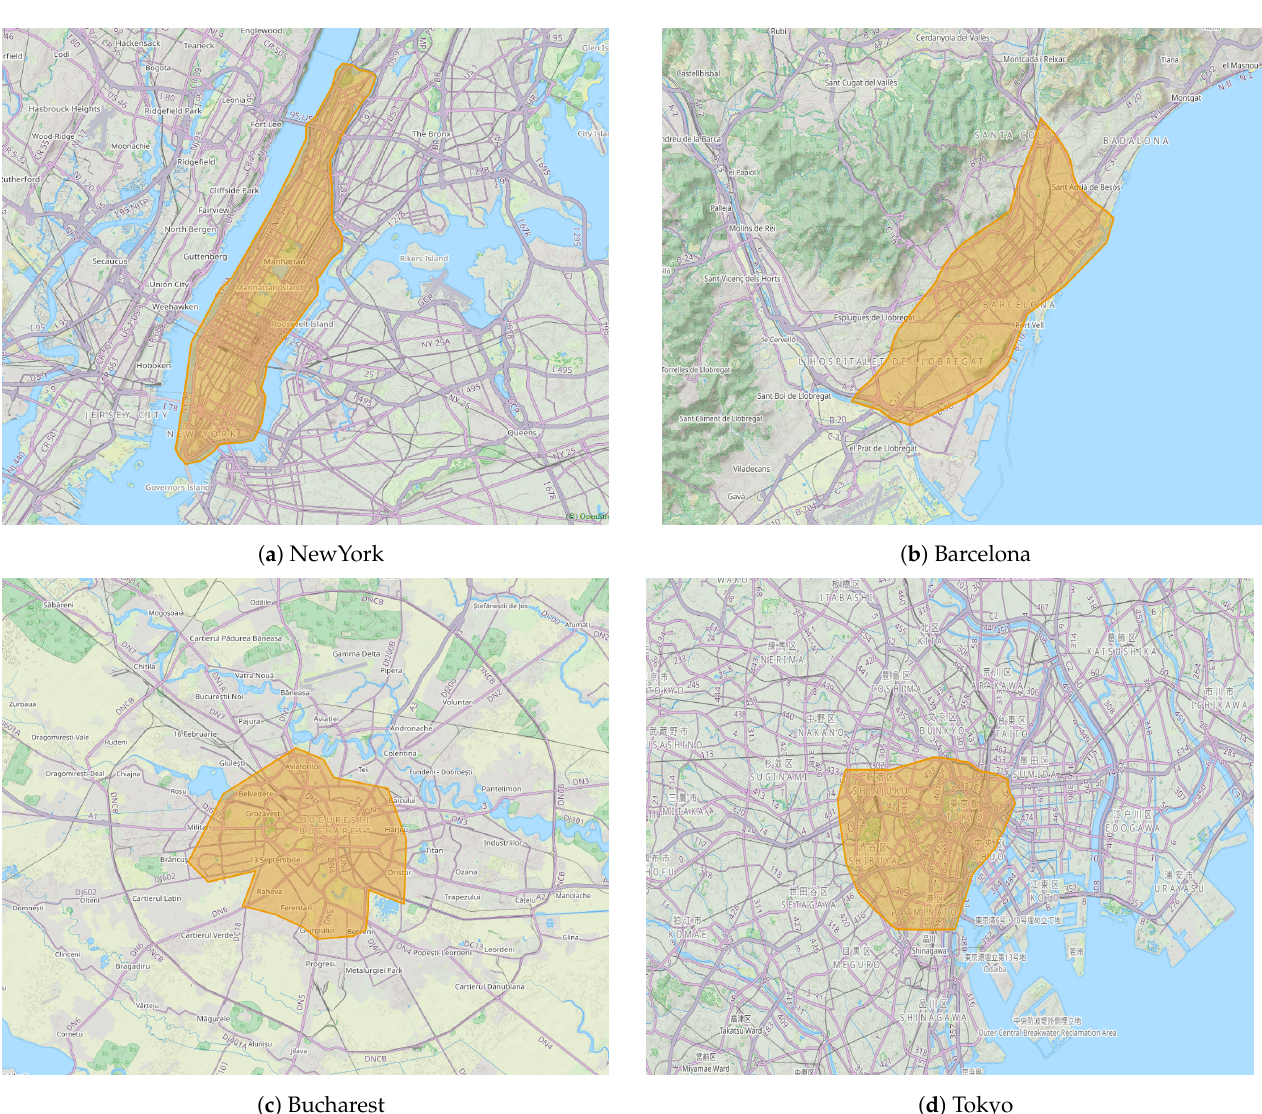
Figure 4. Maps of simulation areas. Orange shaded the highly congested area (65 km 2 ). Table 2. Results for 50 K+ simulated vehicles in